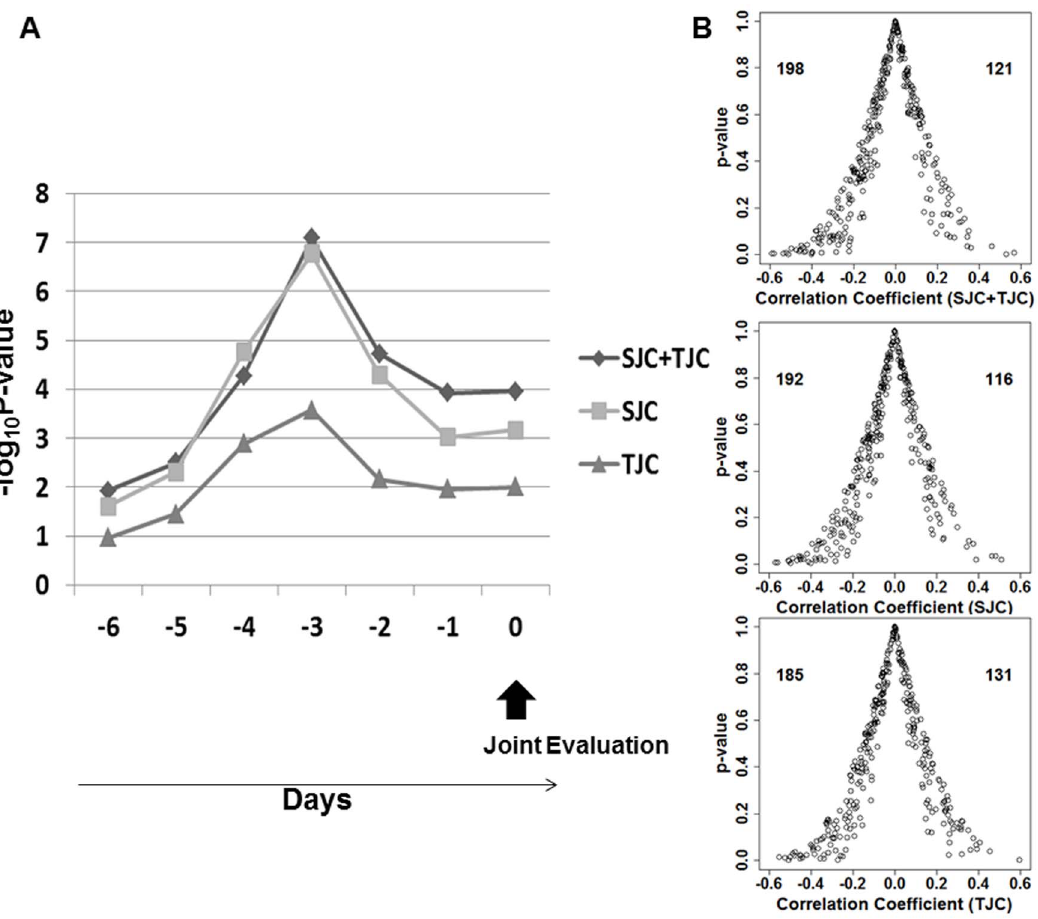
Figure 2. The strongest associations between joint synovitis and air pressure three days before joint evaluations. The 326 patients with more than 20 evaluations were analyzed. A)Associations between air pressure and joint synovitis for the seven consecutive days. Y axis indicates 2 log 10 P-value of Student’s t-test. X axis indicates days before joint evaluations. B)Volcano plots for distribution of RA patients demonstrating positive or negative associations between joint synovitis and air pressure three days before joint evaluations. X and Y axes indicate Spearman’s correlation coefficient and P-value, respectively. Numbers in the panels indicate RA patients showing positive or negative correlation coefficients. Because a part of the patients showed consistent TJC or SJC across all evaluations, the sum of the two numbers in each panel does not make 326.